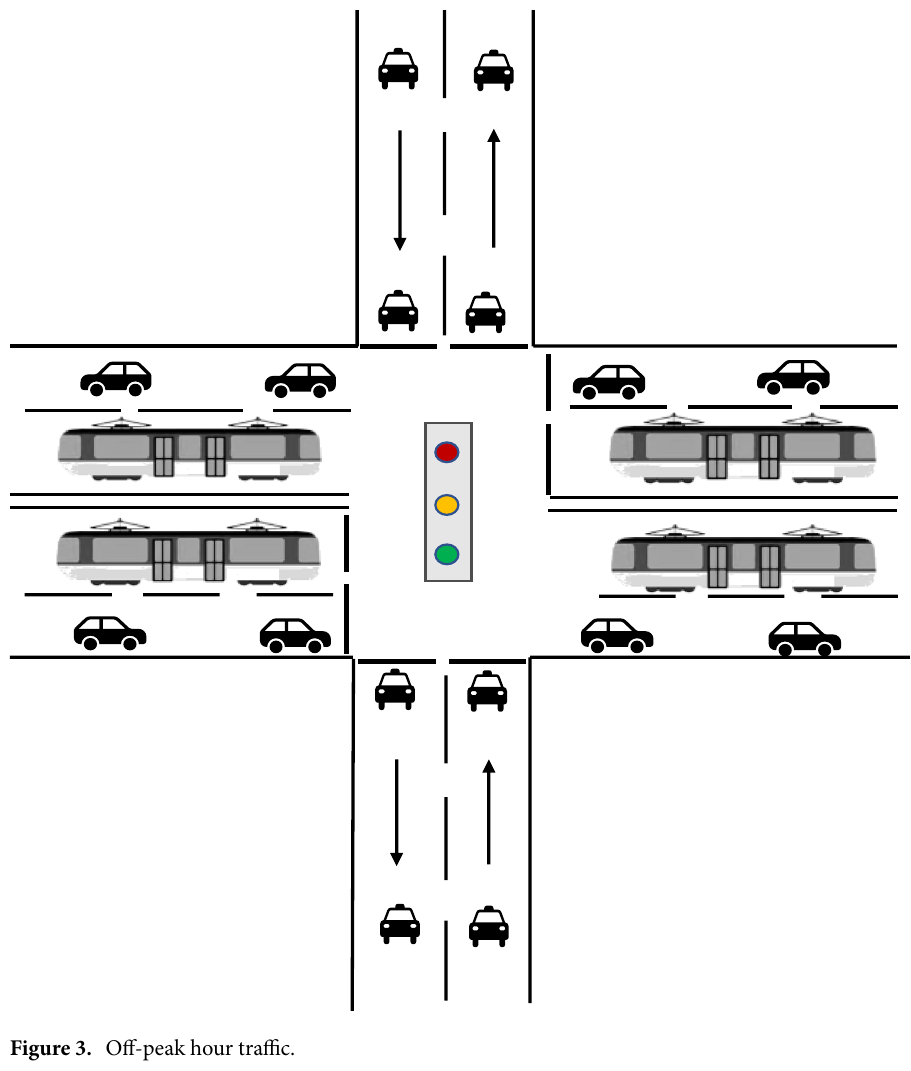
Figure 3. Off-peak hour